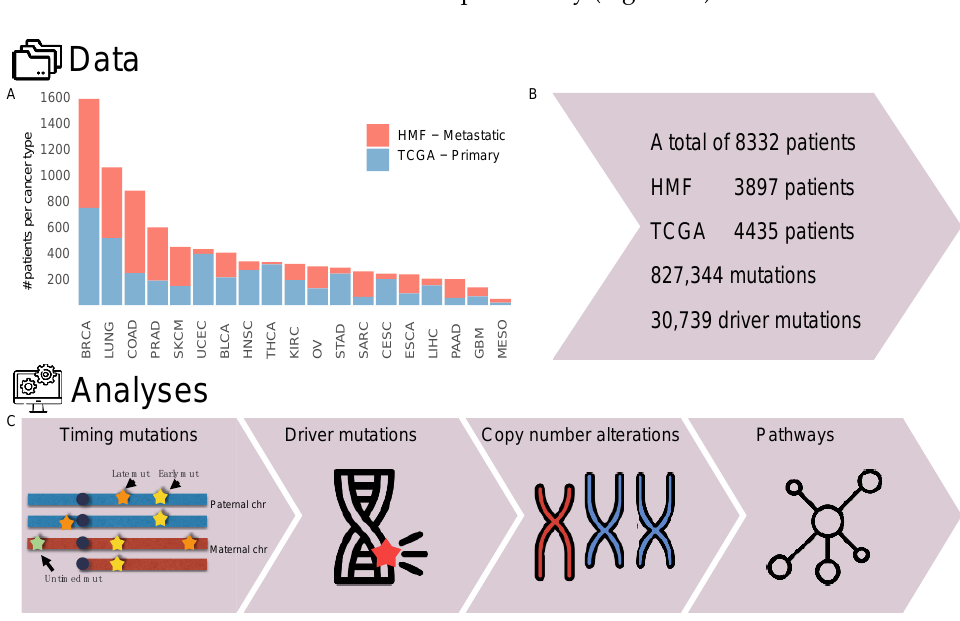
Figure 1. Overview of data and workflow. ( A ) Barplot of number of patients per cancertype. ( B ) Overview of number of patients and number of mutations analysed. ( C ) Workflow showing the outline of the data analysis. First a relative timing of the mutations to the copy number changes was performed. Then, the driver mutations were annotated, and the copy number alterations were analysed, both to summarise them and to annotate driver events. Finally, all driver events were annotated to cancer specific pathways and a pathway enrichment analysis was performed.